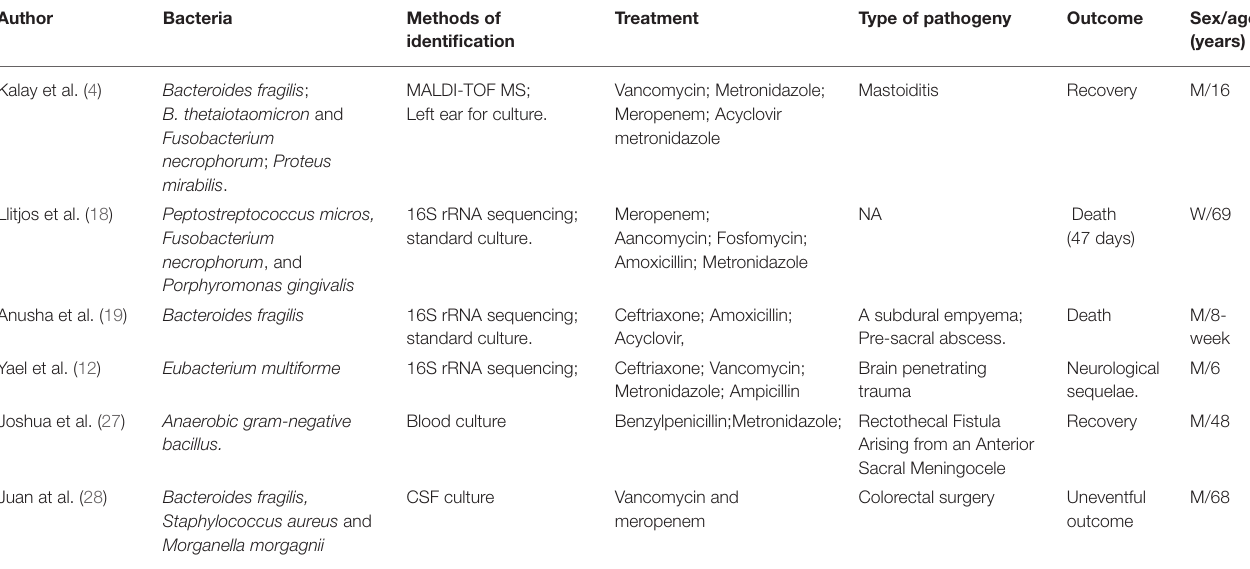
TABLE 1 | Main features of reported cases of anaerobic